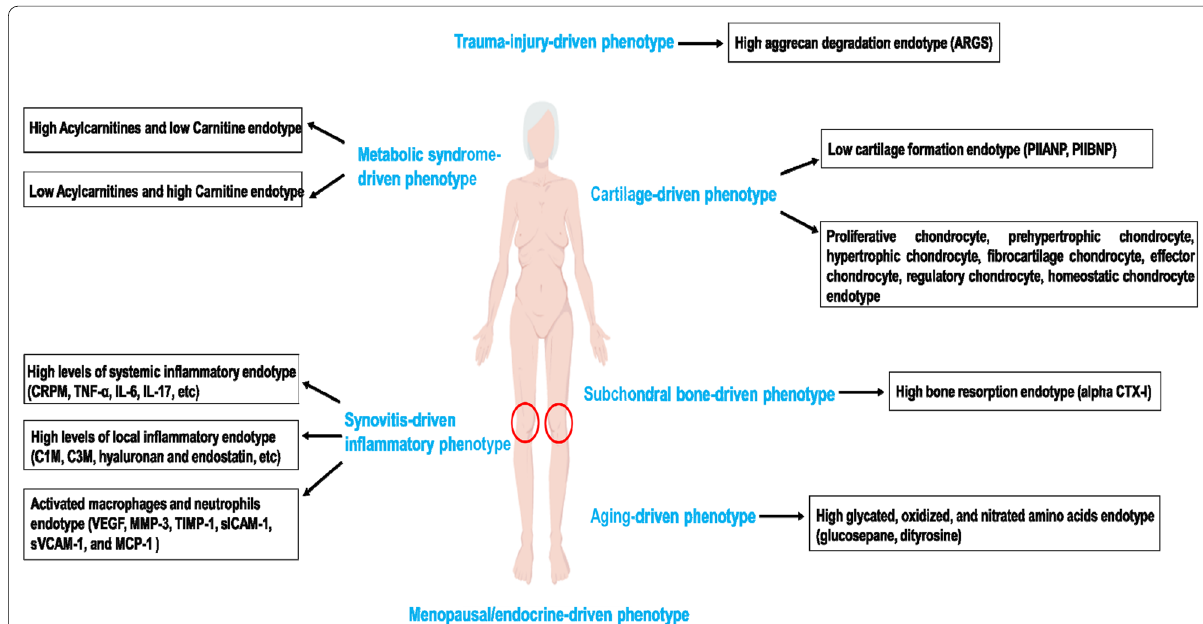
Fig. 5 Emerging phenotypes and endotypes of osteoarthritis. ARGS: N‑terminal neoepitope of the aggrecanase‑mediated aggrecan degradation fragment; C1M: MMP‑derived collagen degradation neoepitopes of collagen I; C3M: MMP‑derived collagen degradation neoepitopes of collagen III; CRPM: MMP‑depended degradation product of C‑reactive protein; CTX‑I: C‑terminal telopeptide of collagen I; IL‑6: interleukin‑6; IL‑17: interleukin‑17; MCP‑1: monocyte chemoattractant protein 1; MMP‑3: matrix metalloproteinase‑3; PIIBNP (N‑terminal propeptide of procollagens IIB); sICAM‑1: soluble intracellular adhesion molecule 1; sVCAM‑1: soluble vascular cell adhesion molecule 1; TNF‑α: tumor necrosis factor‑alpha; TIMP‑1: tissue inhibitor of metallopeptidase inhibitor 1; VEGF: vascular endothelial growth